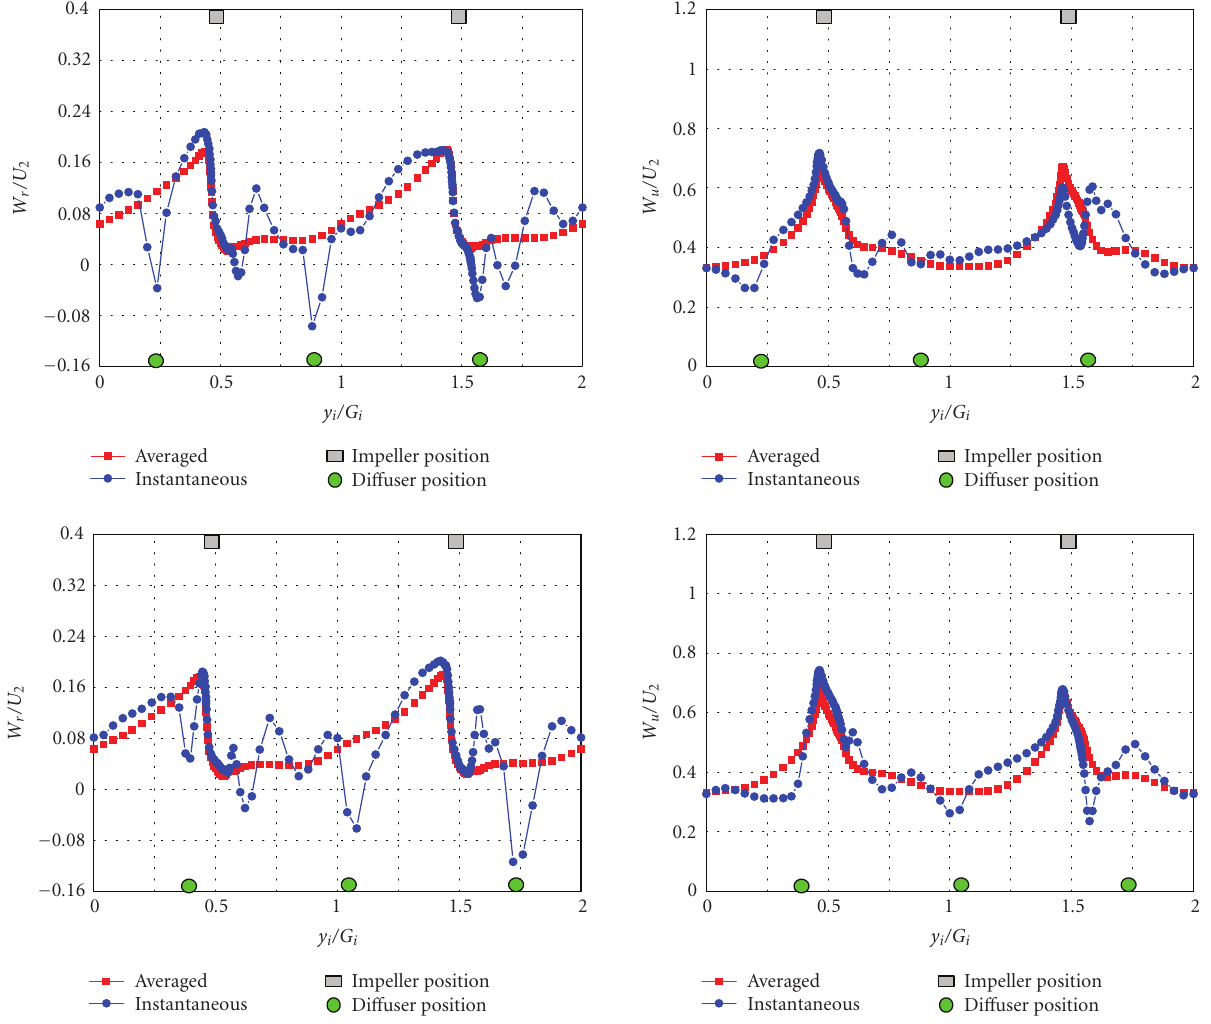
Figure 4: Relative radial and circumferential velocity profiles at the impeller outlet ( R/R 2 = 1 . 01) at midspan Q des